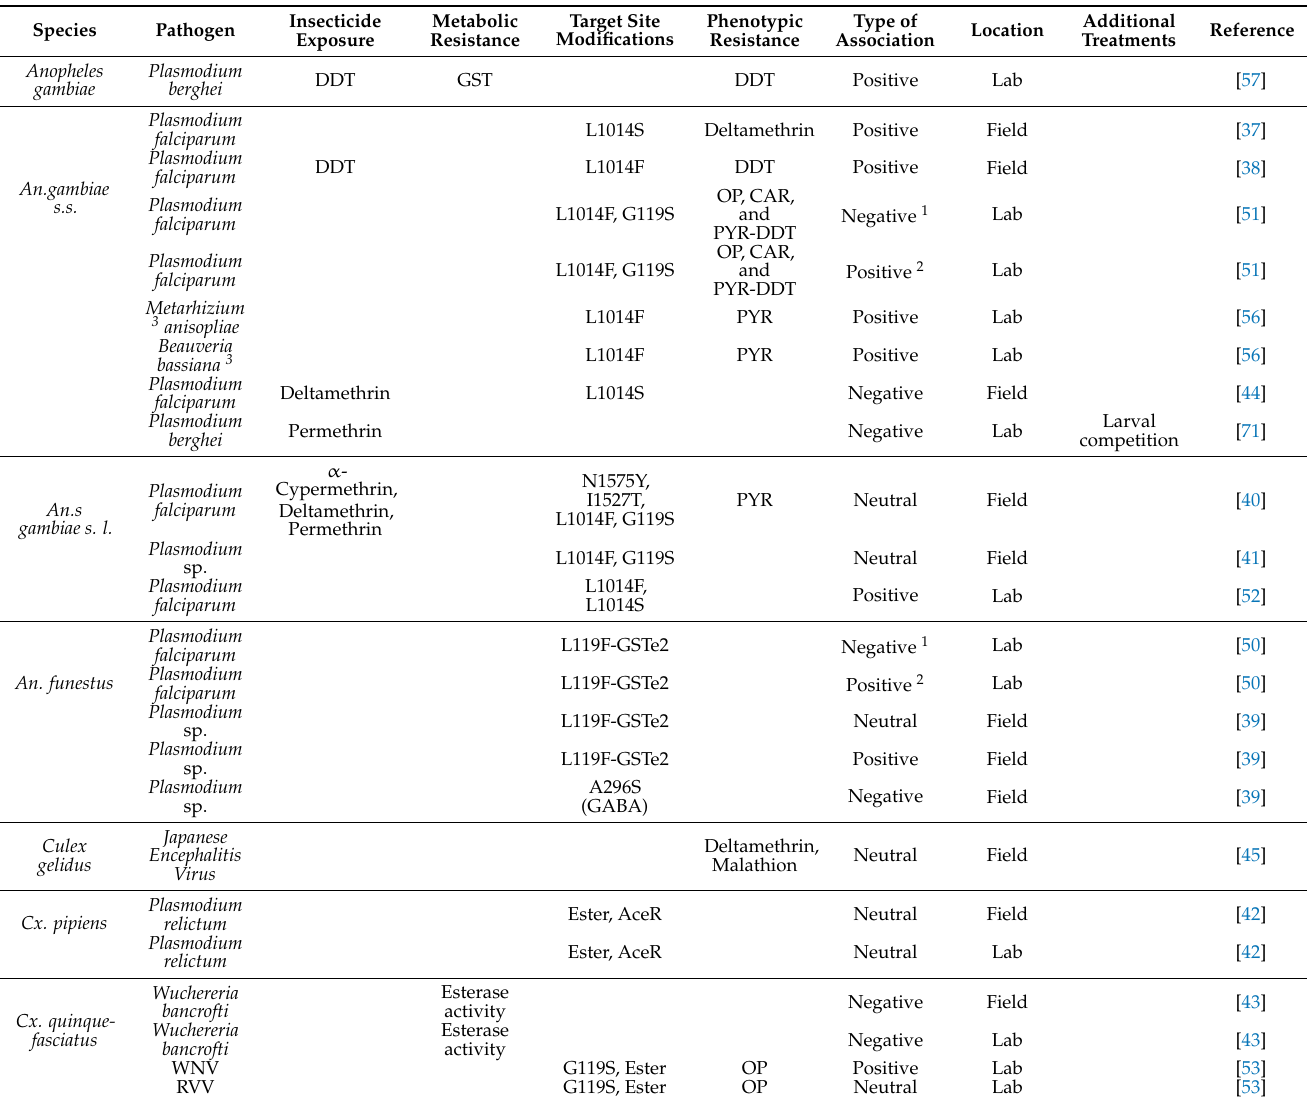
Table 1. Studies aimed at the relationship between insecticide resistance (IR) or exposure to insecti- cides and vector competence